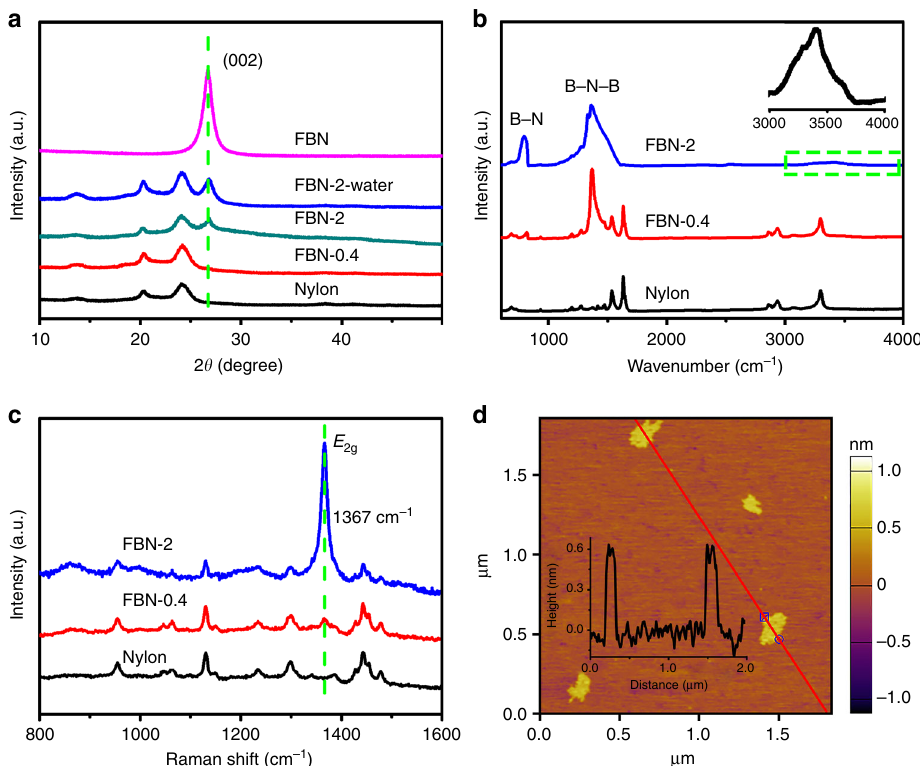
Fig. 2 The structure of the functionalized boron nitride membranes. a XRD patterns of the FBN membrane on nylon. b Raman spectra of the FBN membrane on nylon. c FTIR-ATR images of the FBN membrane on nylon. d AFM of the FBN fl akes, and the inset shows the corresponding height pro fi